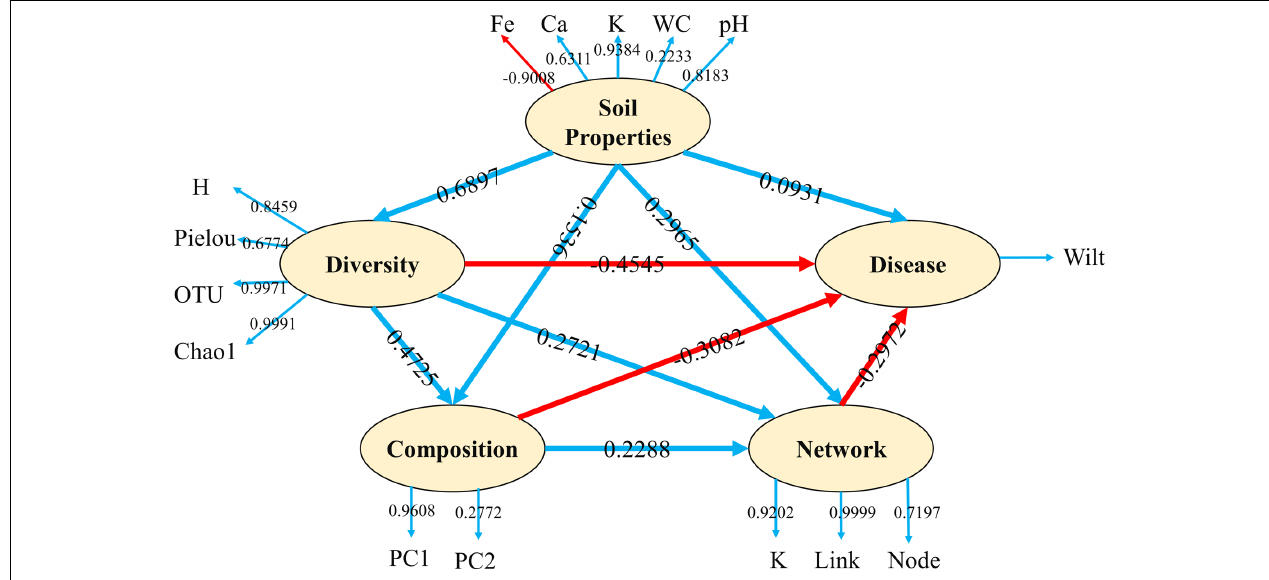
FIGURE 5 | Partial Least Squares Path Modeling (PLSPM). Blue lines represent positive effects and red lines represent negative effect. Numbers on the lines in the PLSPM model are the ‘total effects’ values. Numbers on the lines out of the PLSPM model are the ‘weight’ contributions. WC, water content; H, Shannon diversity index; K, average